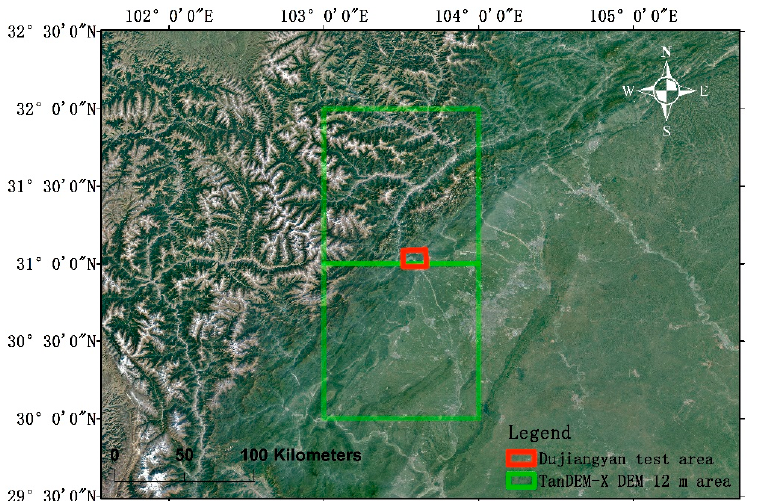
Figure 3. The location of the 12 m TanDEM-X DEM data, the red box area is the Dujiangyan TomoSAR test area, the two green boxes are the two 12 m TanDEM-X DEM tiles (1 degree × 1 degree for a tile) of the 12 m DEM map of the two tiles shown in Figure 5, and the background image is a Google Earth image (image source: Landsat image/Copernicus).